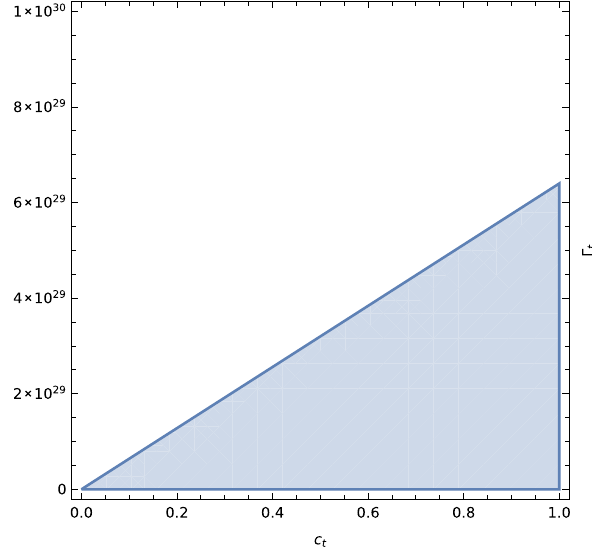
Fig. 1 Allowed region of N ( t ) amplitude of two point